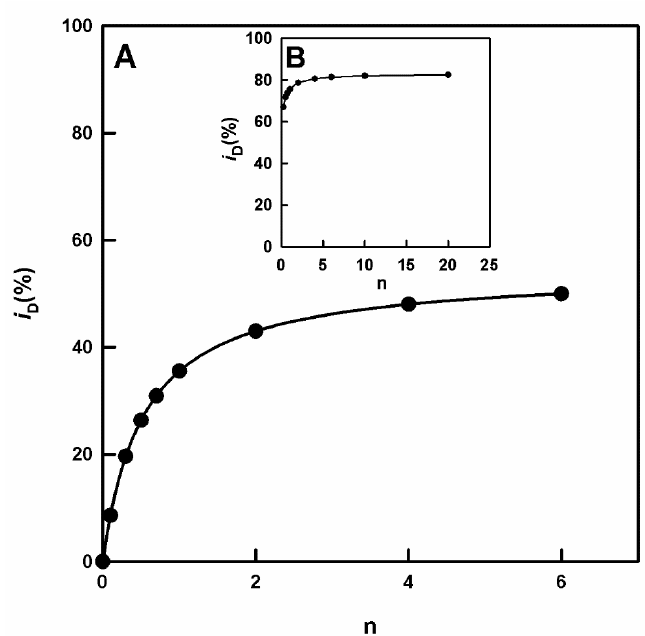
Figure 9. ( A ) and ( B ). Solution of the ambiguity between uncompetitive and mixed type (2) inhibi- Figure 9. ( A , B ). Solution of the ambiguity between uncompetitive and mixed type (2) inhibition. tion. Obtaining 𝑖 Obtaining i D by varying [ D ] at fixed inhibitor concentration. ( A ) ( [ I ] 0